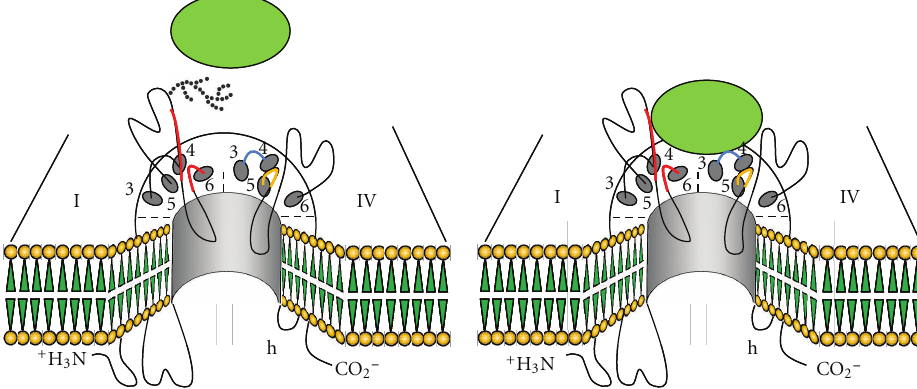
Figure 2: Hypothesis on deglycosylation-created modulation of scorpion toxins to VGSCs. For glycosylated VGSC, the sialic carbohydrates (dotted branch) shield the binding site and thus prevent toxin binding (left). If the sialic carbohydrates are deleted, the toxin accessibility to the binding site is facilitated because of the absence of the oligosaccharide groups and consequently modulate the gating of VGSCs